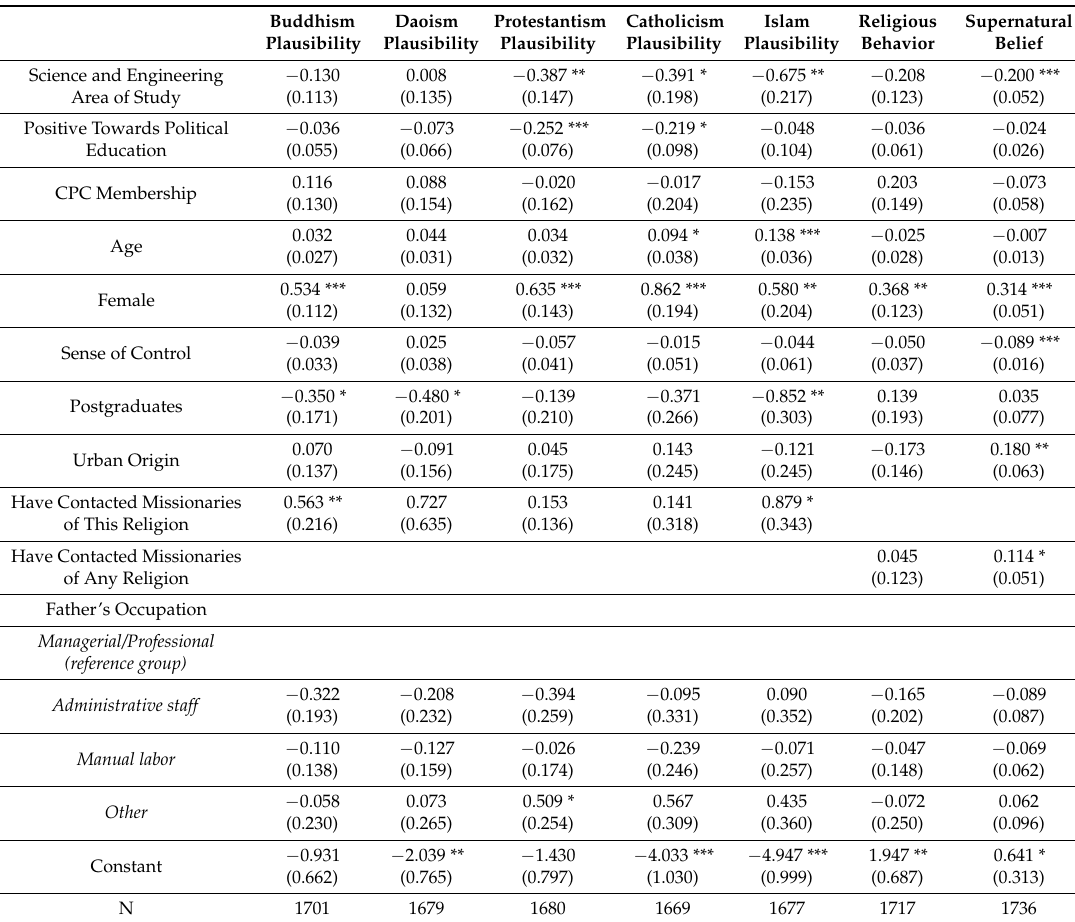
Table 2. Regression Model Coefficients for the Perceived Plausibility of Five Religions, Religious Behavior, and Supernatural Belief of College Students in